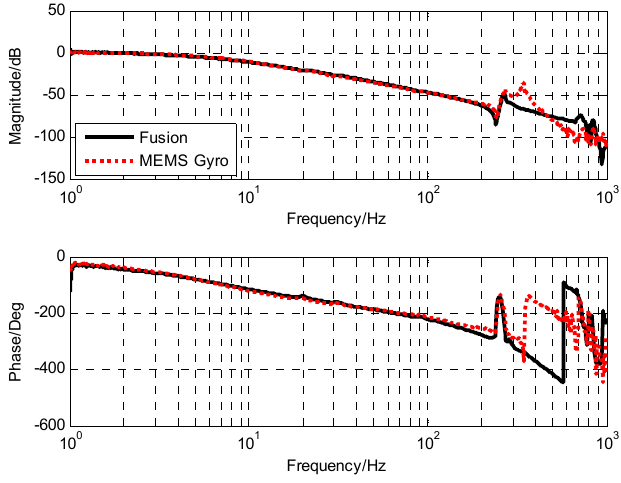
Figure 15. The platform characteristics.